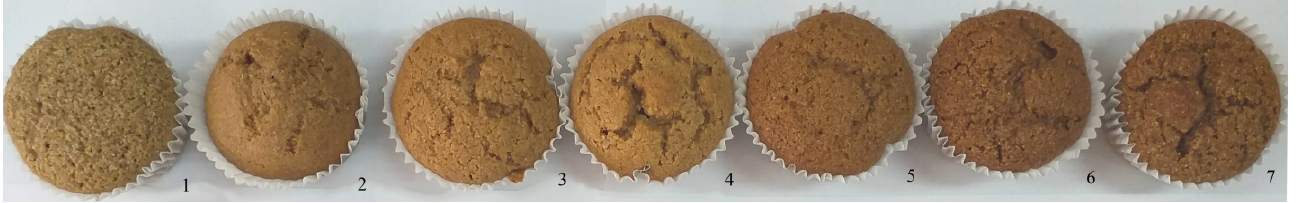
Figure 1. Muffin samples with Lyo apple powder and OT+Lyo apple powder. Samples are numbered according to Table 1. according to Table